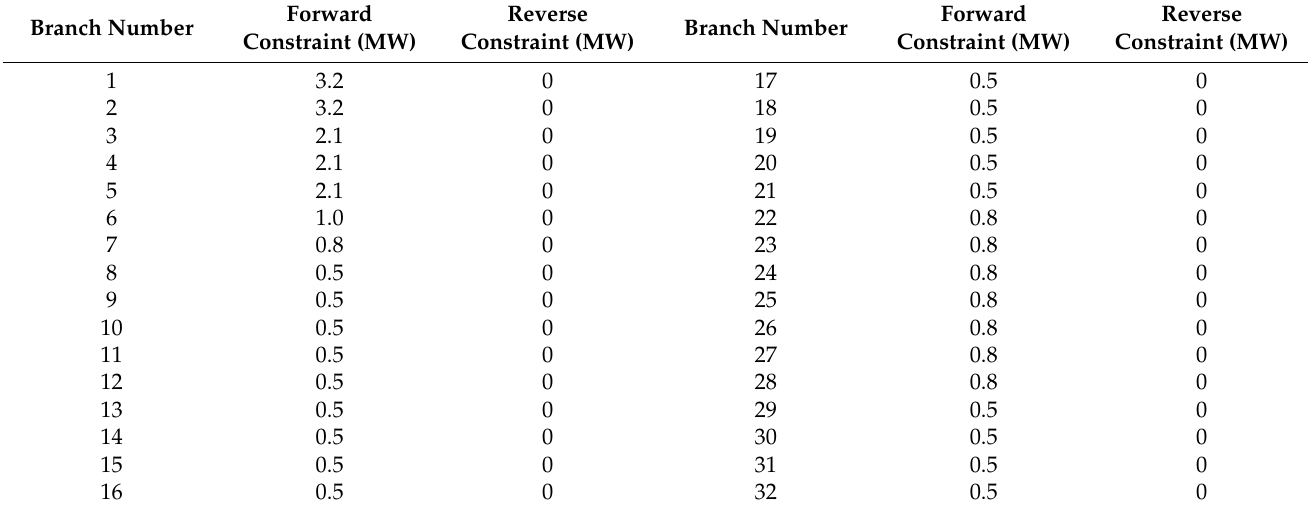
Table 4. Parameters for power constraints of DN branches.